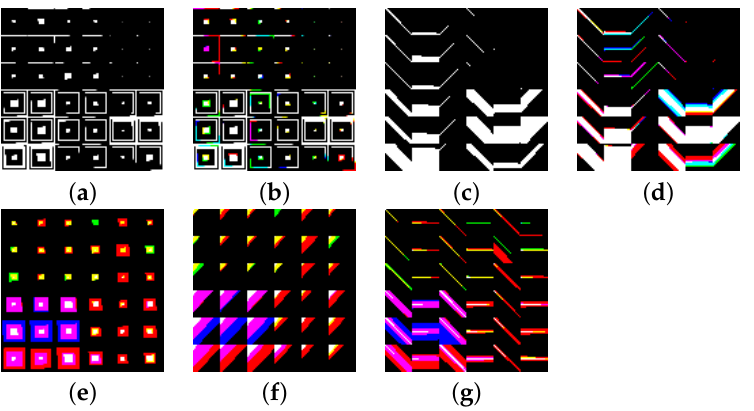
Figure 8. Samples of the image representation designs. ( a ) A-1, ( b ) A-2, ( c ) A-3, ( d ) A-4, ( e ) B-1, ( f ) B-2, and ( g )